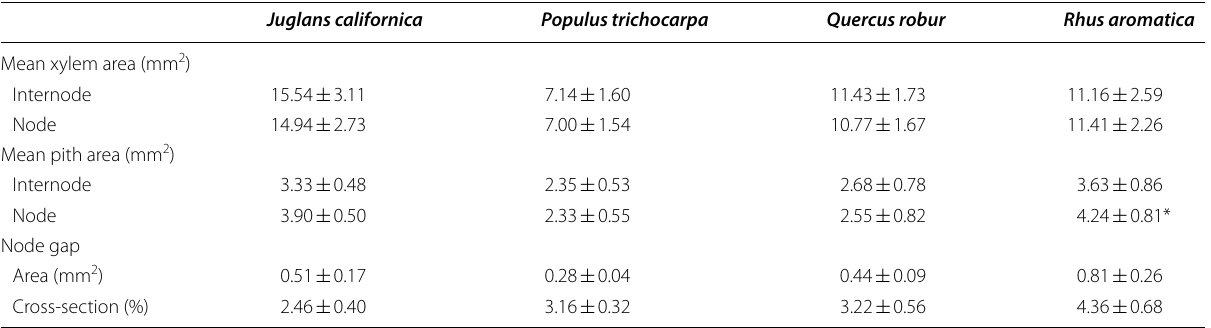
Table 3 Means ( 1 SE) for cross-sectional areas of stems measured within nodes and internodes of four species, ± including mean xylem area and mean pith area for the node and internode regions